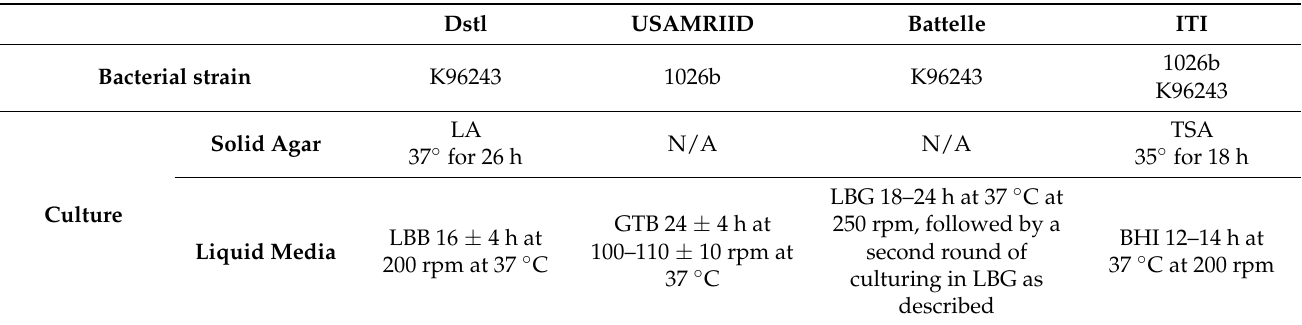
Table 2. B. pseudomallei challenge